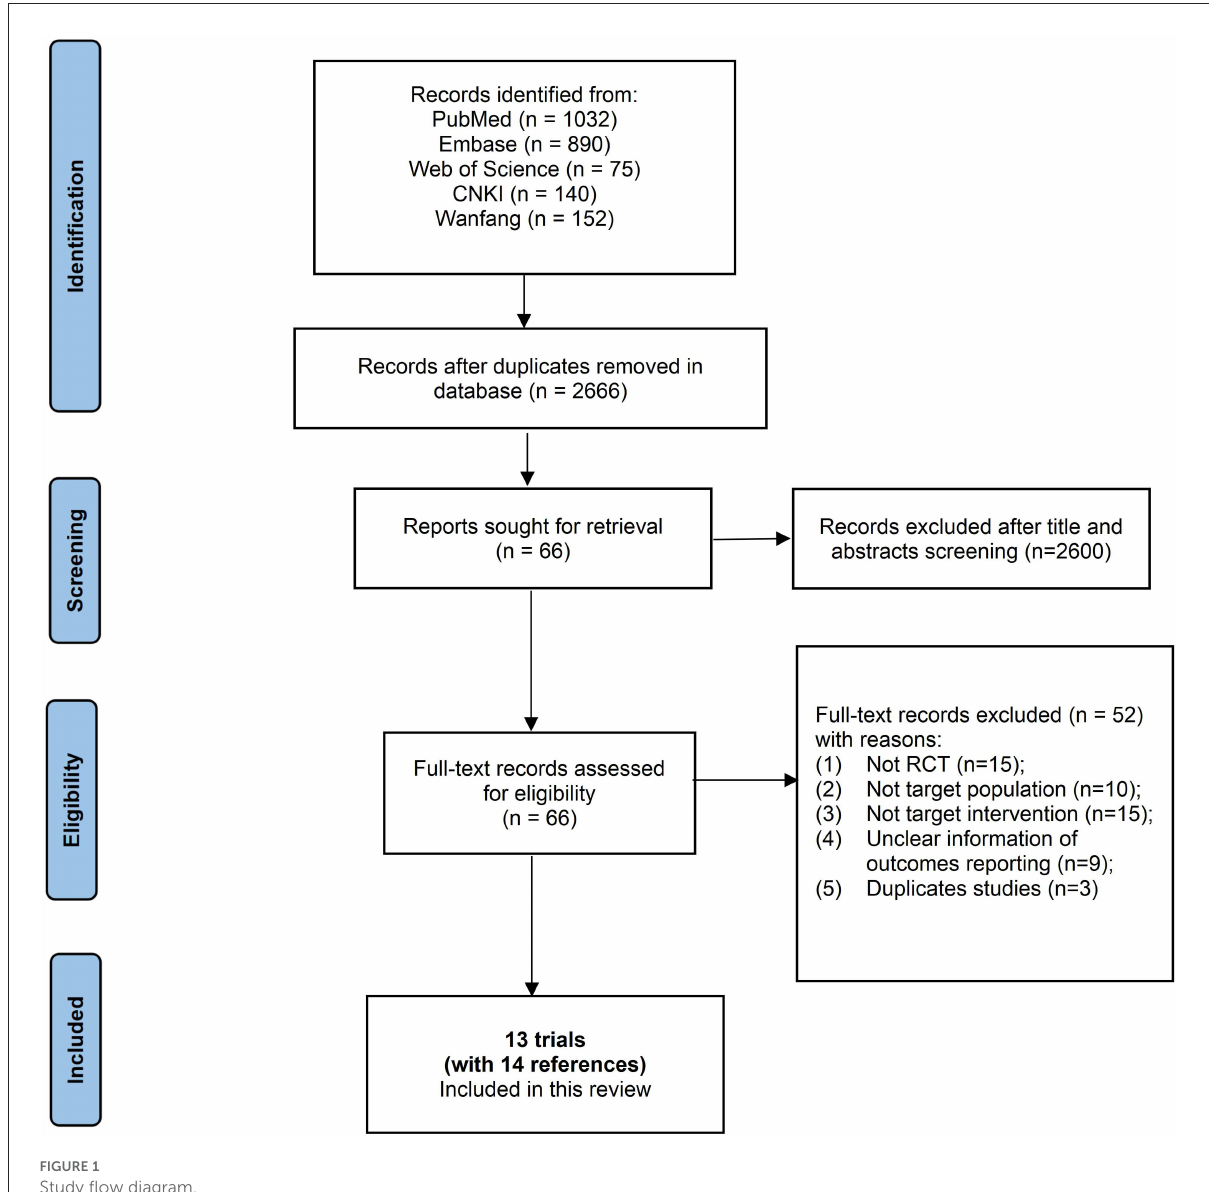
FIGURE1 Study flow